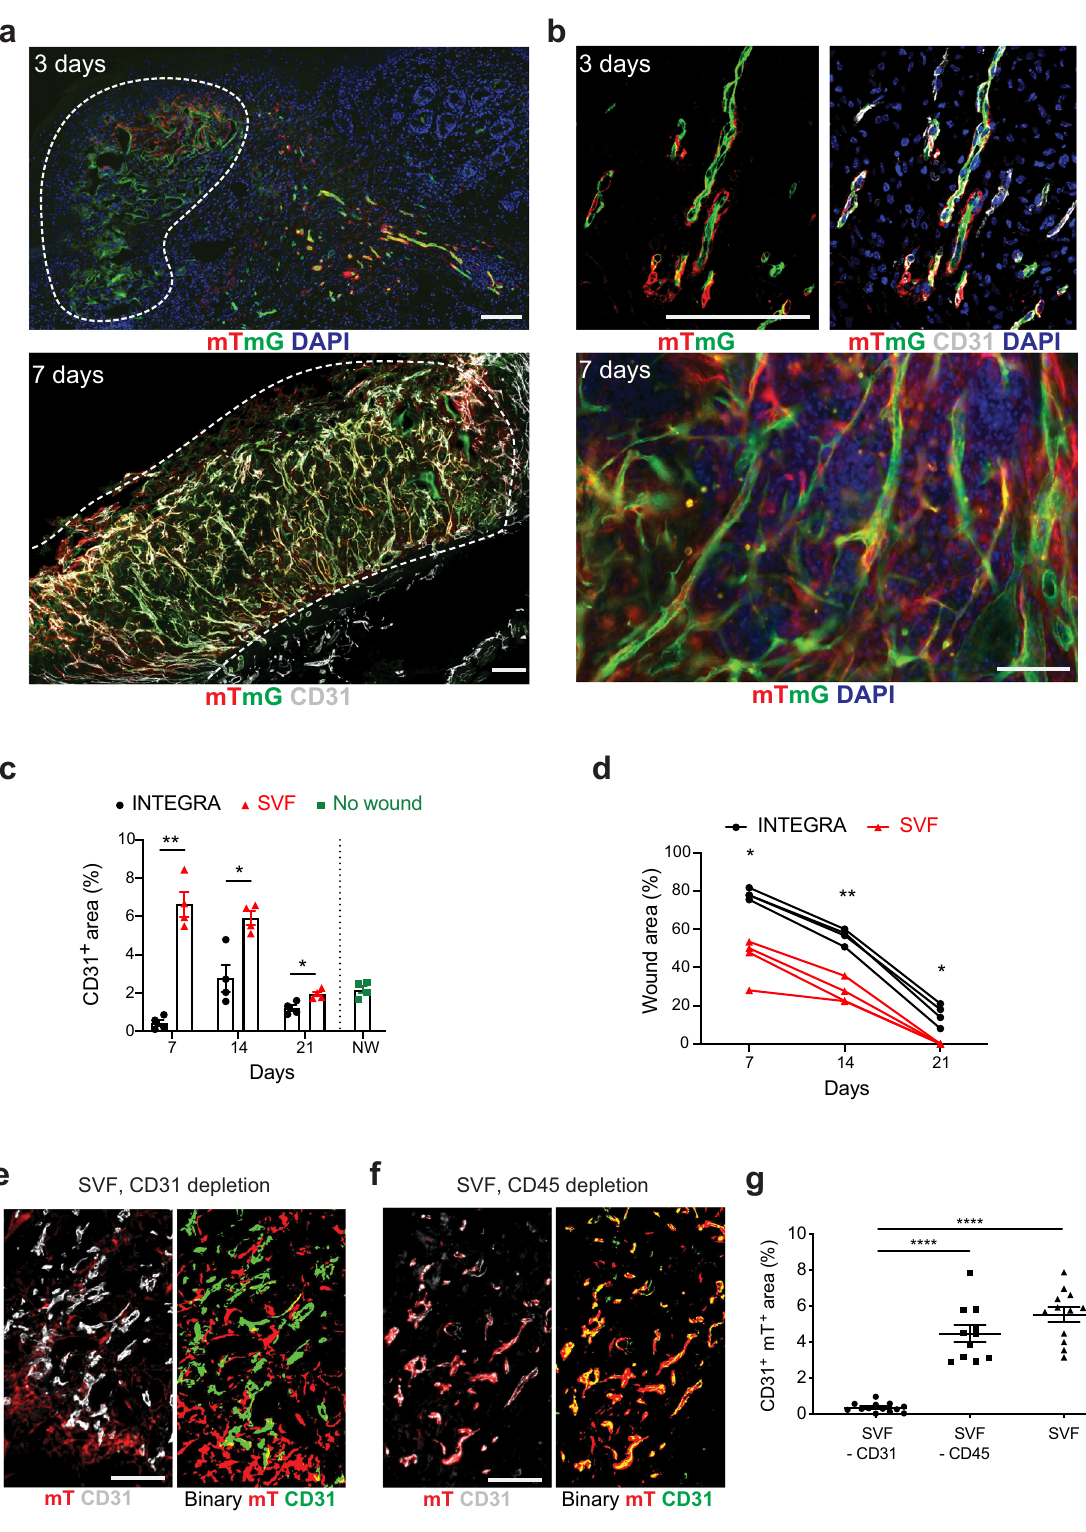
in ischemic control wounds at 21 days, it was restored to a normal level in SVF-treated wounds (Fig. 2c for quanti fi cation and Supplementary Fig. 2b, c for representative images). The increased vascularization also promoted full re-epithelization similar to a